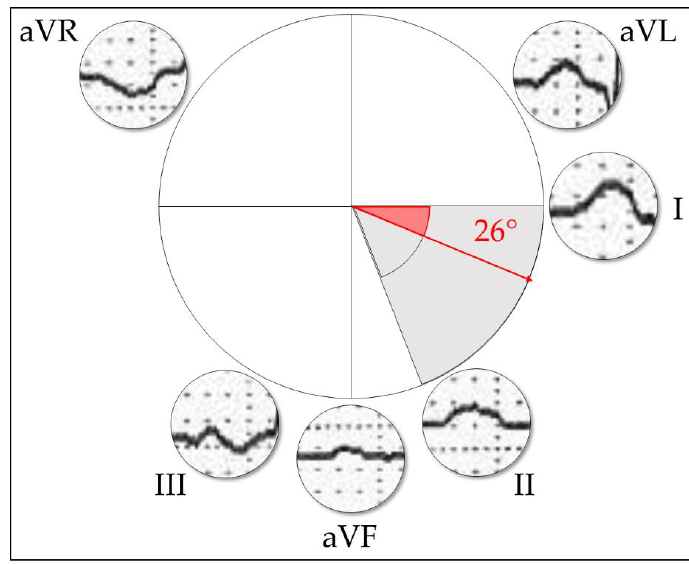
Figure A5. P-wave axis in the frontal plane.